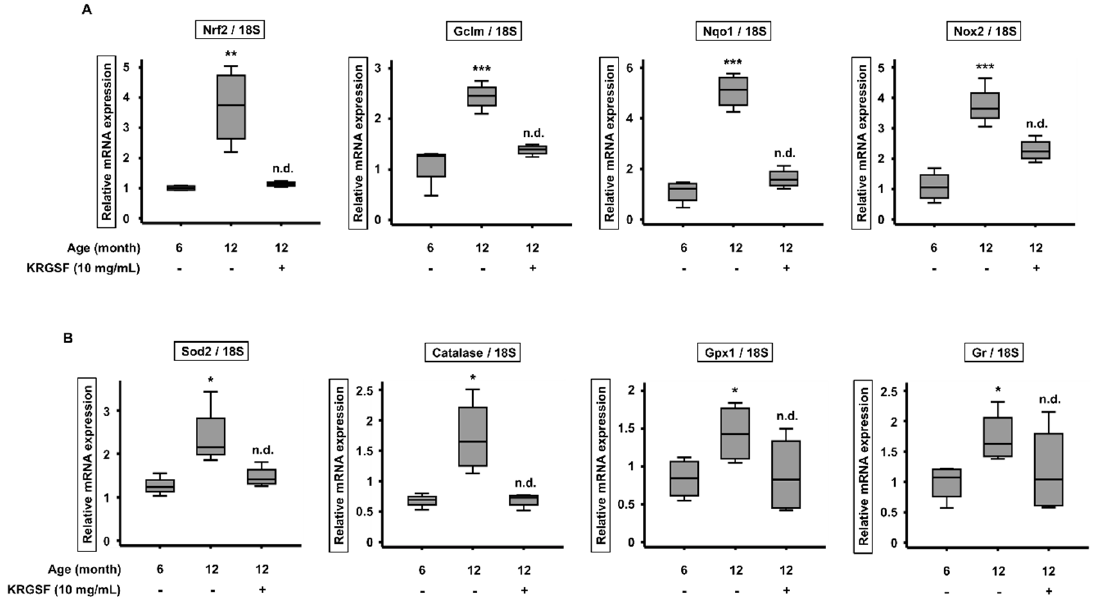
Figure 5. KRGSF inhibits the age-related increase in expression of intracellular oxidative stress response genes. RNA was isolated from ovaries and quantitative RT-PCR analysis was